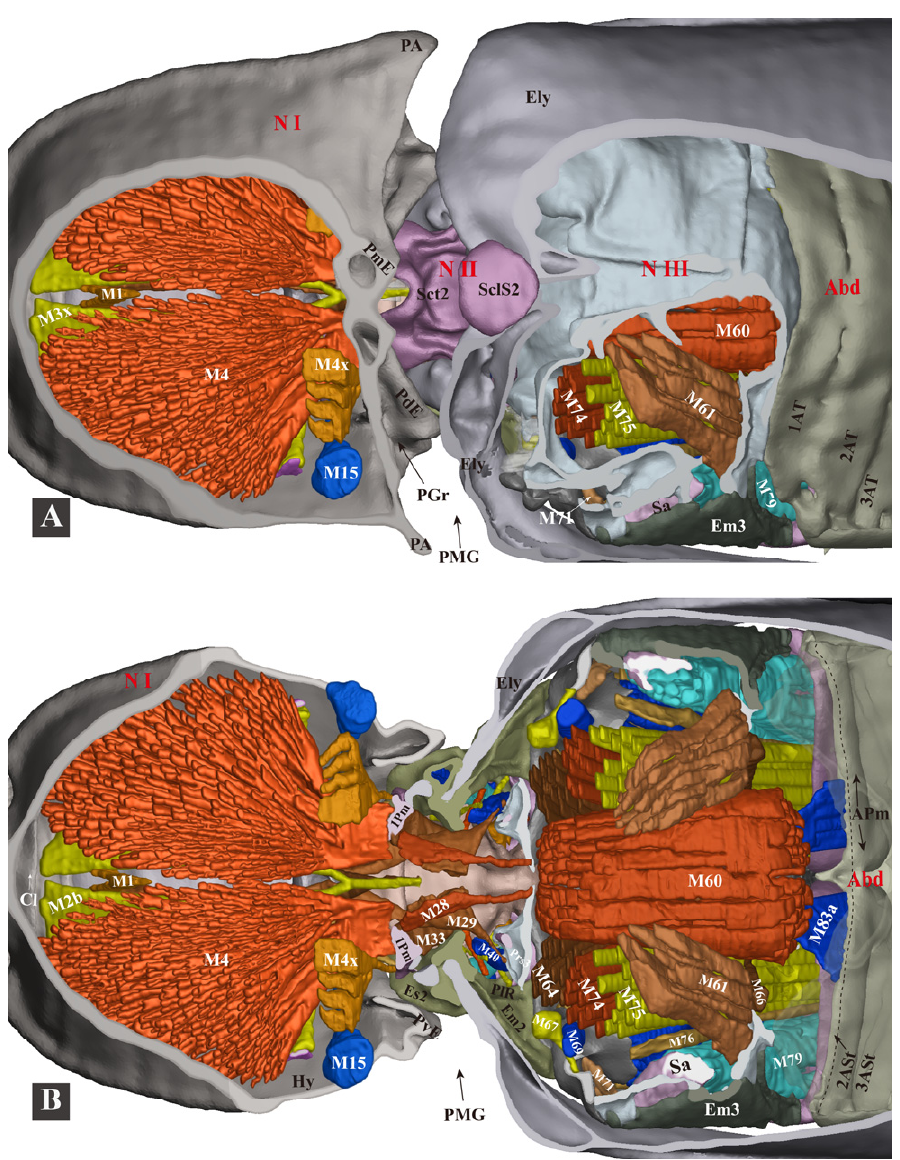
Figure 9. Three-dimensional reconstructions of the thoracic skeleton and musculature of Campsoster- nus auratus , dorsal view, part 1. The head of the model is facing left, and the skeleton of the model is cut in the frontal (coronal) plane at different layers ( A , B ) to show internal musculature; for technical information and abbreviations, see Section 2 ‘Materials and